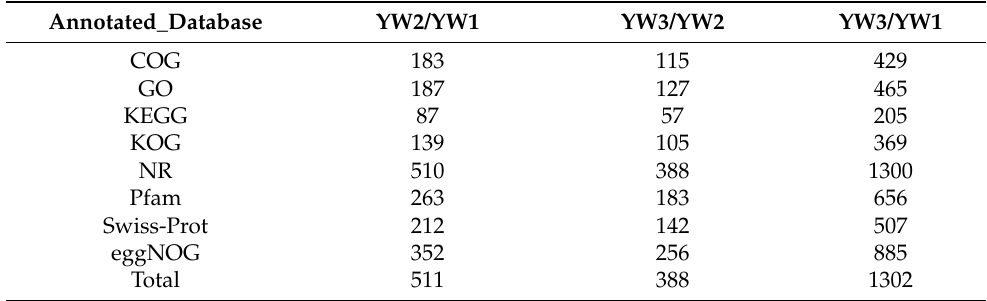
Figure 2. Gene Ontology (GO) functional enrichment of differentially expressed genes. ( a ) Venn diagrams show the number of differentially expressed genes (DEGs) between different developmental stages and the number of shared DEGs. The left Venn diagram indicates the upregulated genes, and the right one represents the downregulated genes. ( b ) GO enrichment for shared DEGs between different comparisons. Venn diagrams represent DEGs shared among different comparisons (from left to right): DEGs in YW2/YW1 and YW3/YW1; DEGs in YW3/YW1, but not in YW2/YW1. BP: biological process; MF: molecular function; CC: cellular component. The GO terms with p values < 0.01 are shown in color, otherwise, they are shown in grey. ( c ) Expression profiles of DEGs in carbohydrate metabolic process. The square represents the log 2 (FPKM + 1) ratio of the expression level in different developmental stages. Table 2. The number of differentially expressed genes annotated in multiple public